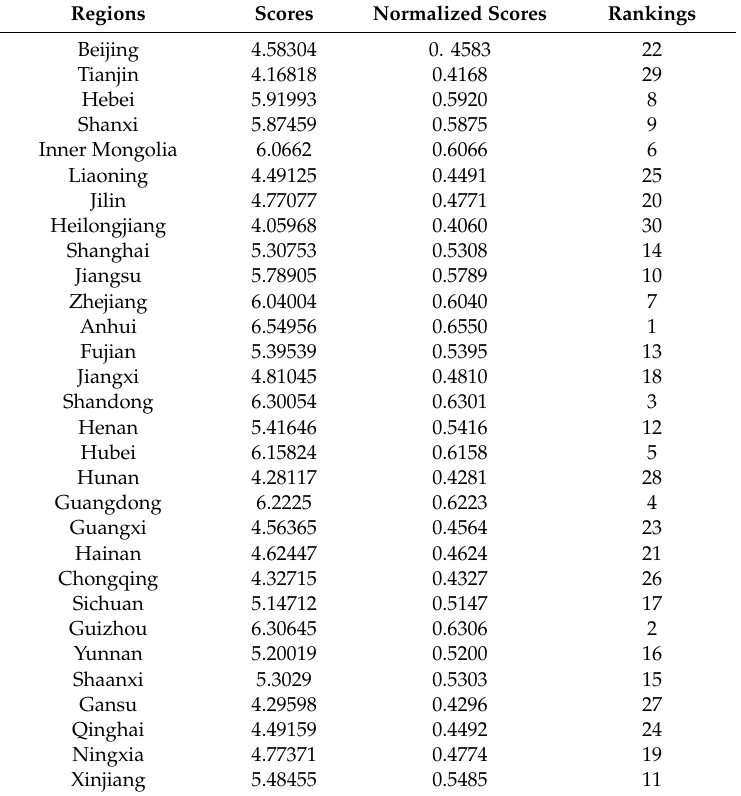
Table 3. Final e ffi ciency scores and rankings of the 30 regions undertaken in this